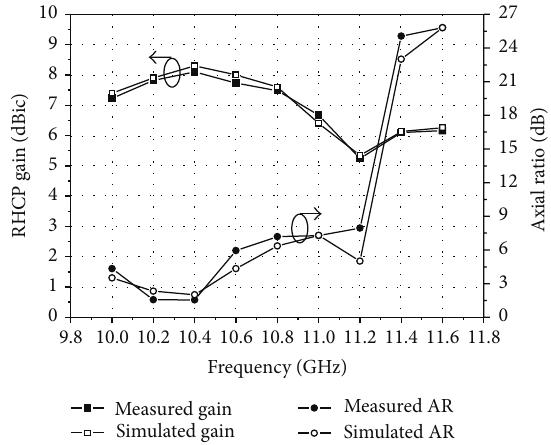
Figure 4: Measured peak gain and AR versus